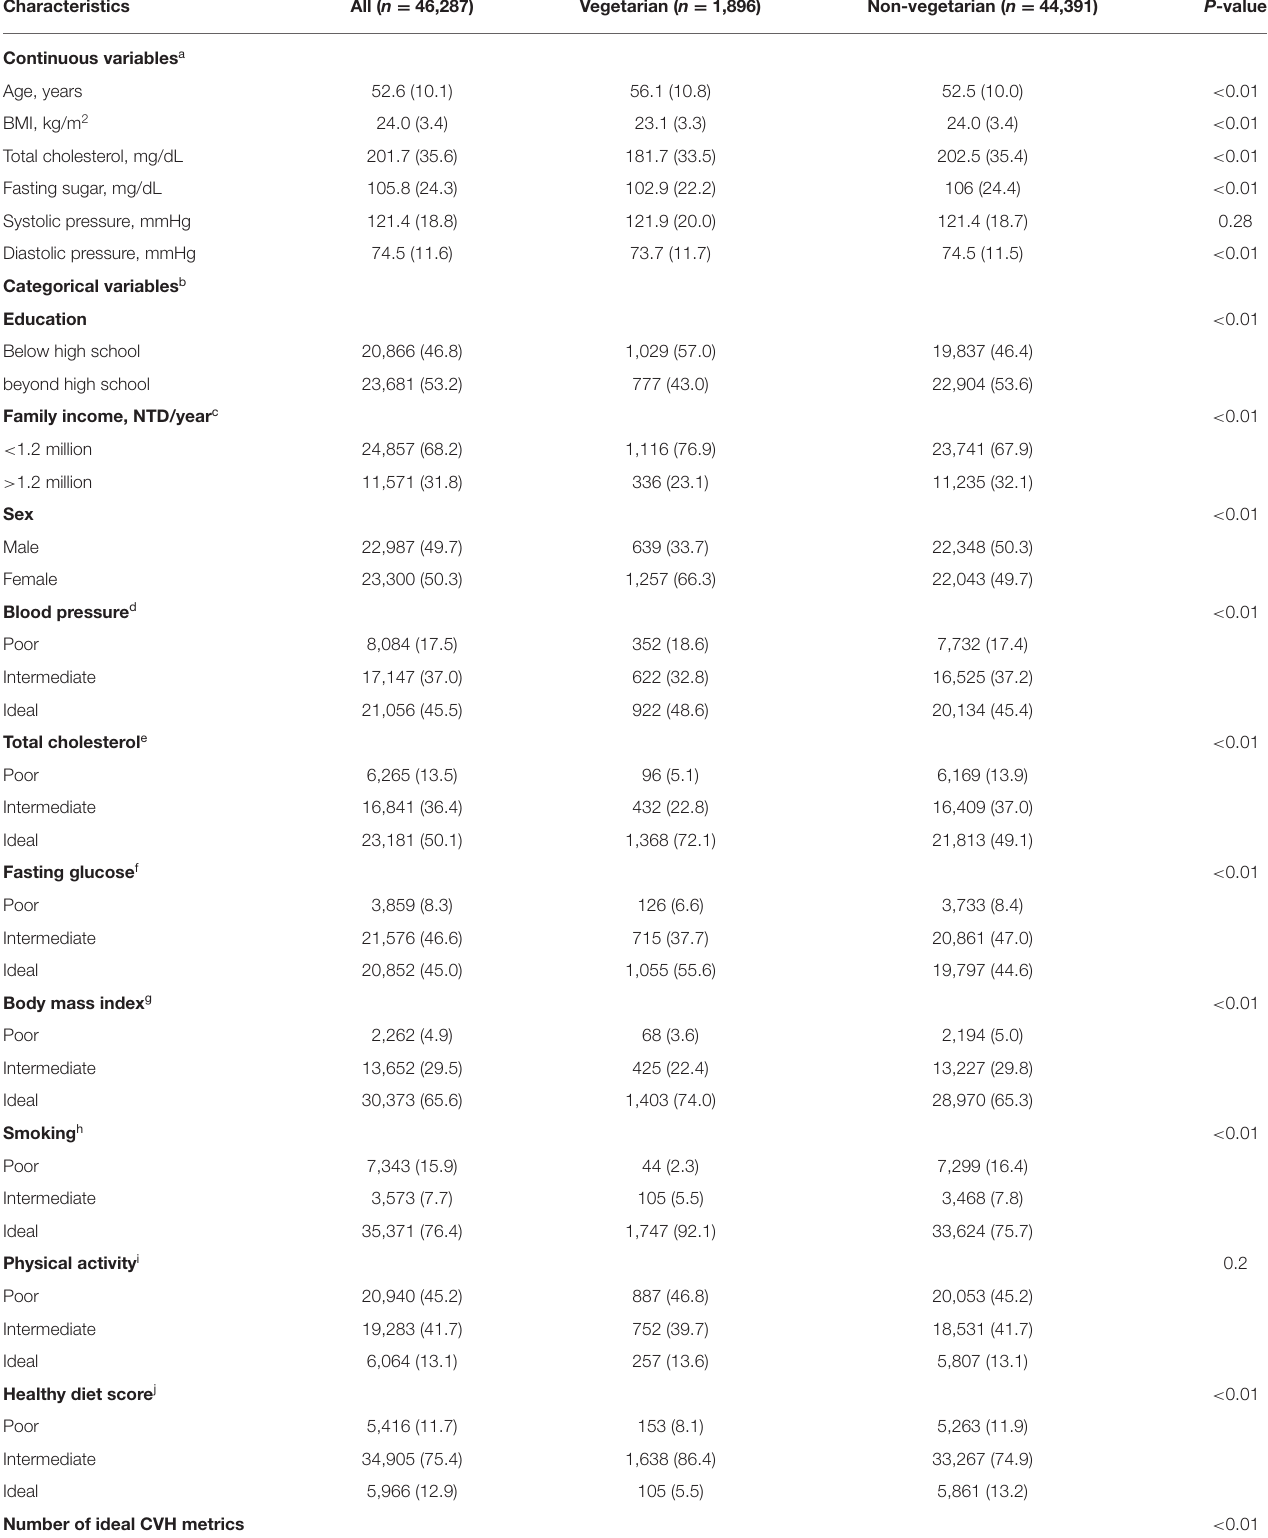
TABLE 1 | Characteristics of the study participants.